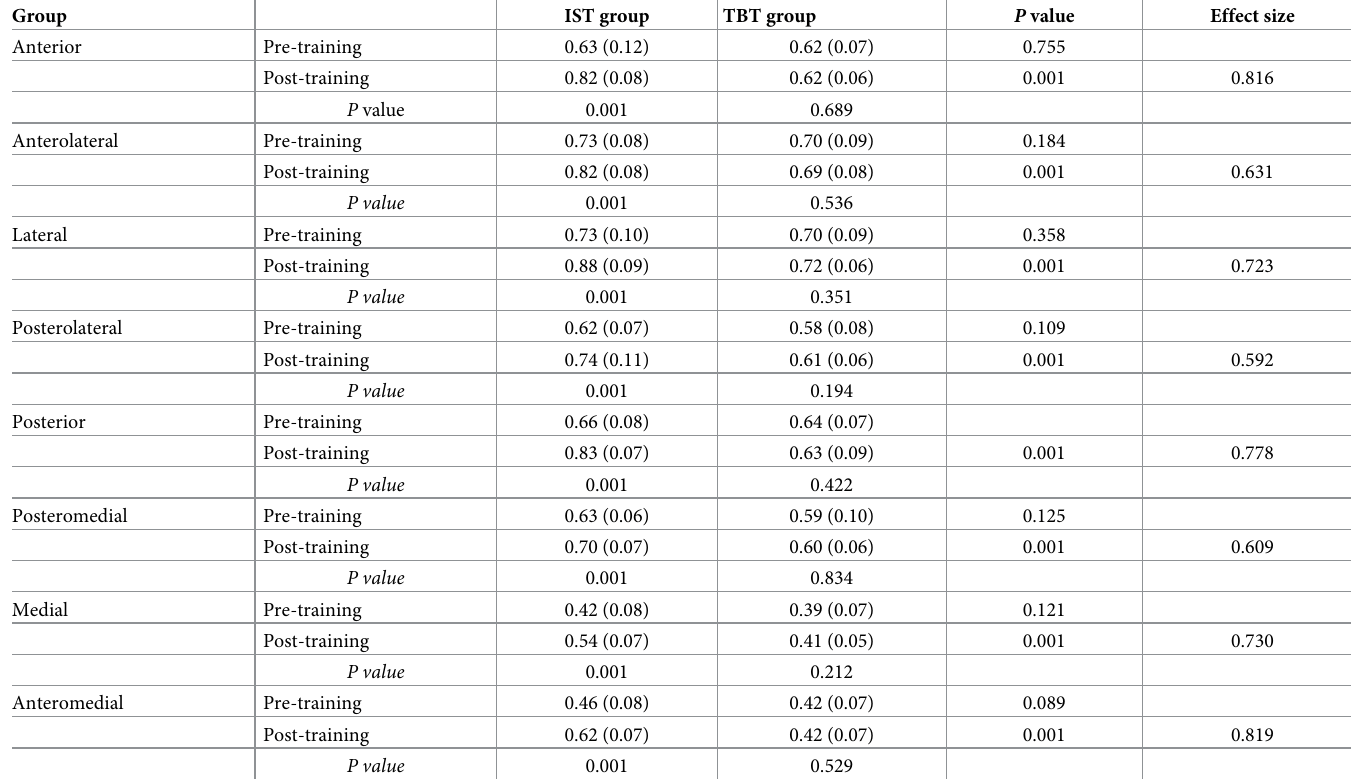
Table 3. Balance ability of the IST and TBT groups revealed by the SEBT score before and after the interventions.